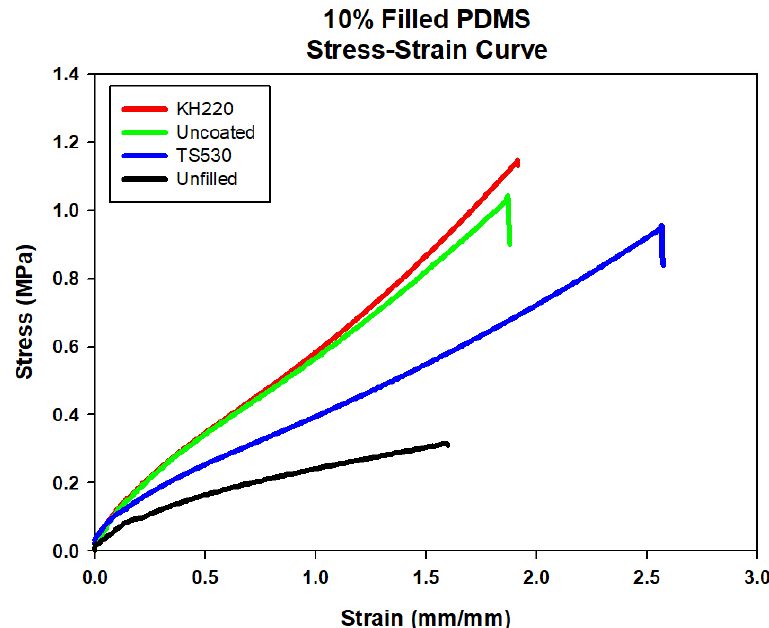
Figure 6. Stress–strain Curve of Unfilled and 10% Filled PDMS with Three Filler Types.